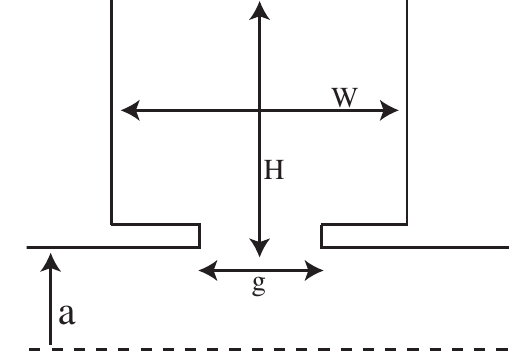
FIG. 5. The cavitylike structure parametrized by its width W , its height H , and its opening size g (the gap